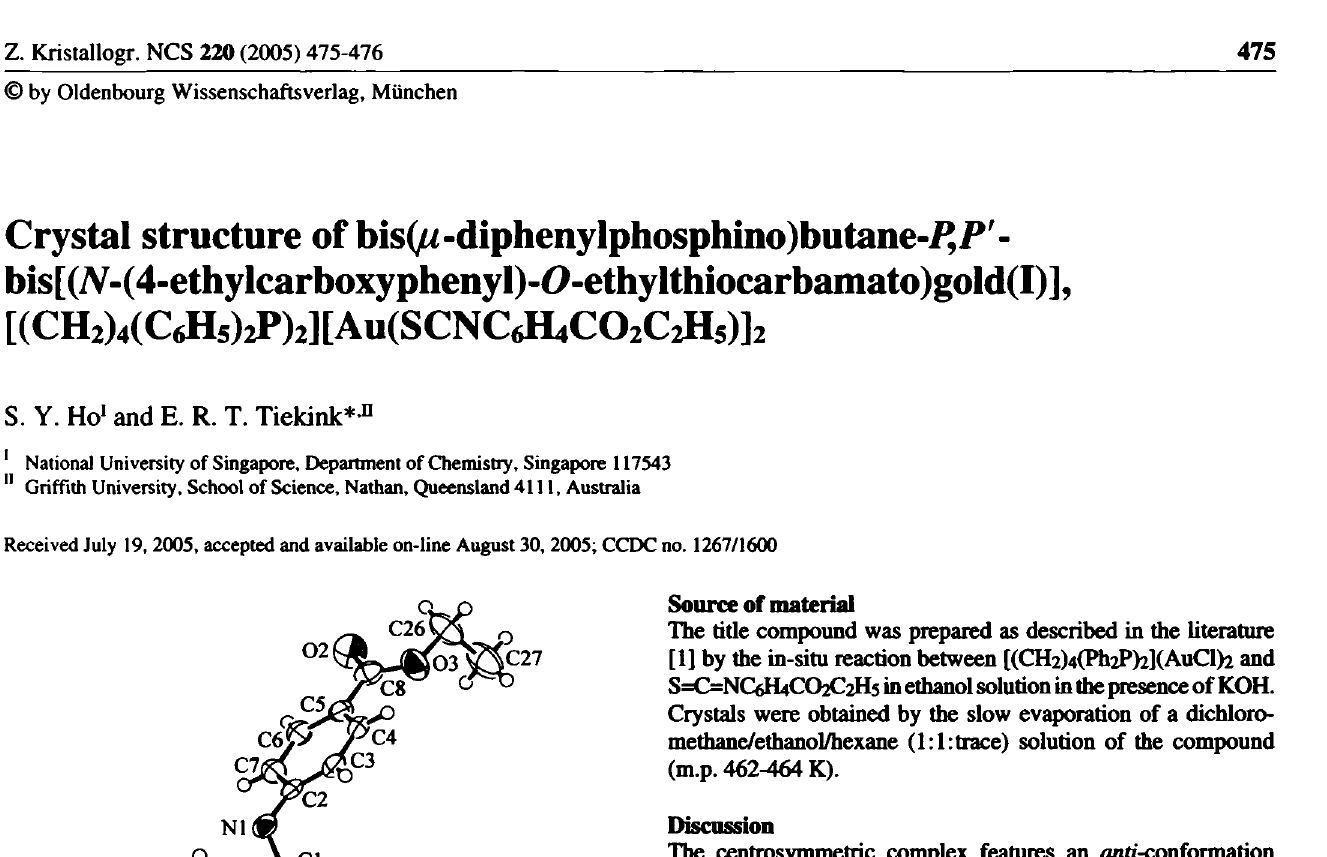
Table 1. Data collection and handling.